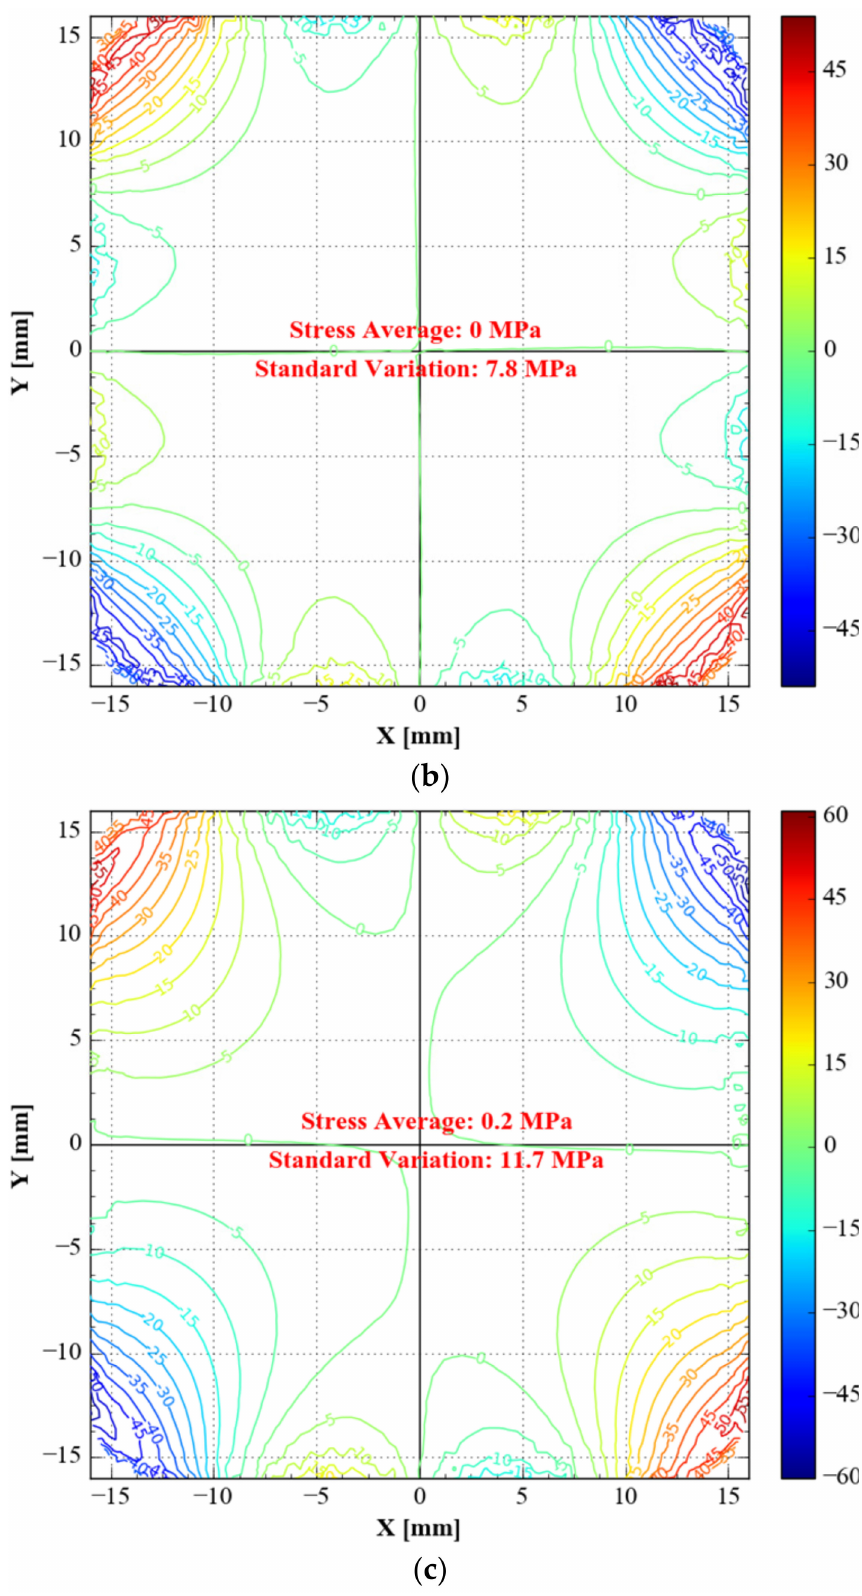
Figure 13. S 12 of the three specimens in the gauge zone. ( a ) Type A: unoptimised specimen; ( b ) type B: specimen with topology-only optimization; ( c ) type C: specimen with topology combined with shape